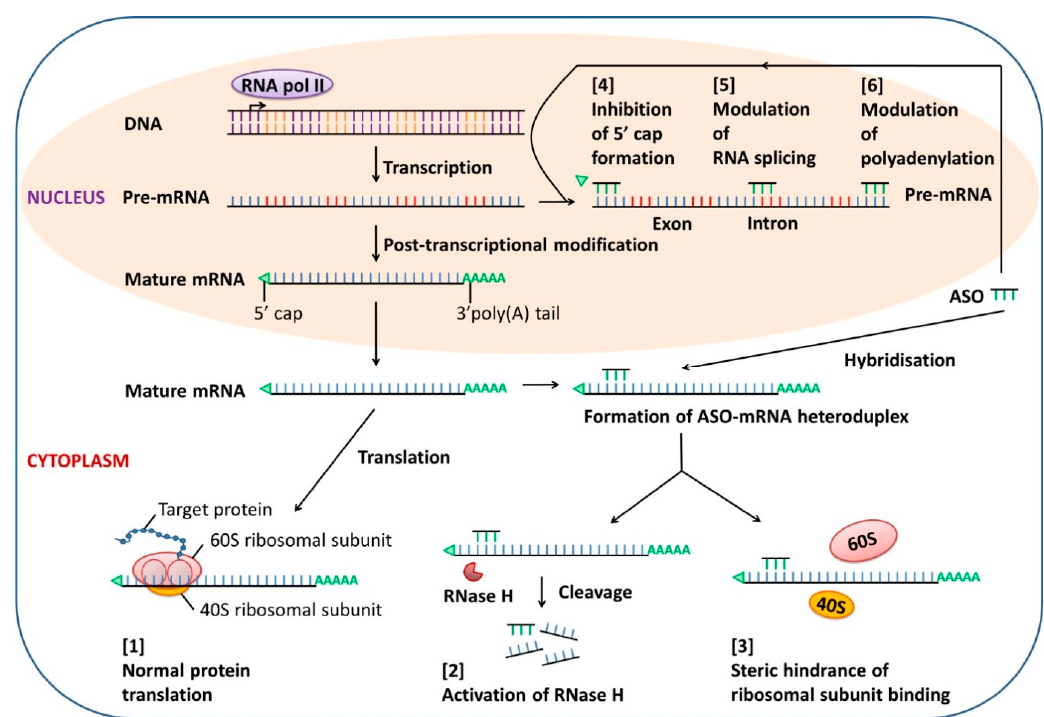
Figure 1. Mechanisms of action of antisense oligonucleotide (ASO). In the absence of ASO, normal gene transcription and protein translation are maintained [1]. ASO can enter cells by endocytosis and hybridize with target mRNA in the cytoplasm. Formation of an ASO-mRNA heteroduplex activates RNase H, leading to the degradation of target mRNA [2], or interferes with ribosomal assembly by steric hindrance, resulting in inhibition of translation [3]. Both actions will knock down the target protein. In addition, the binding of ASO to the target pre-mRNA in the nucleus can regulate mRNA maturation through [4] inhibition of 5 ′ cap formation, [5] modulation of RNA splicing, and [6] blockade of polyadenylation.